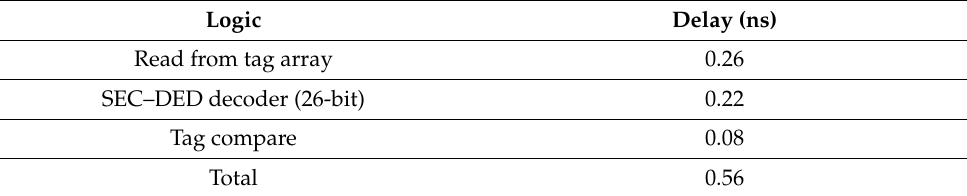
Table 4. Tag read path timing of the conventional design scheme.